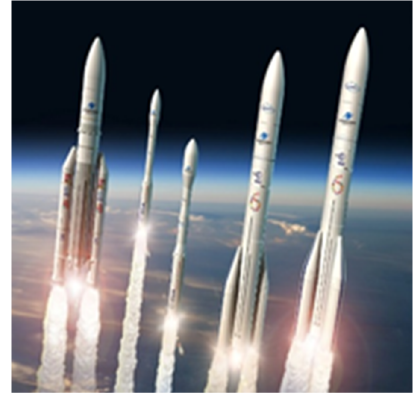
Figure 3. Typical VEGA launcher.